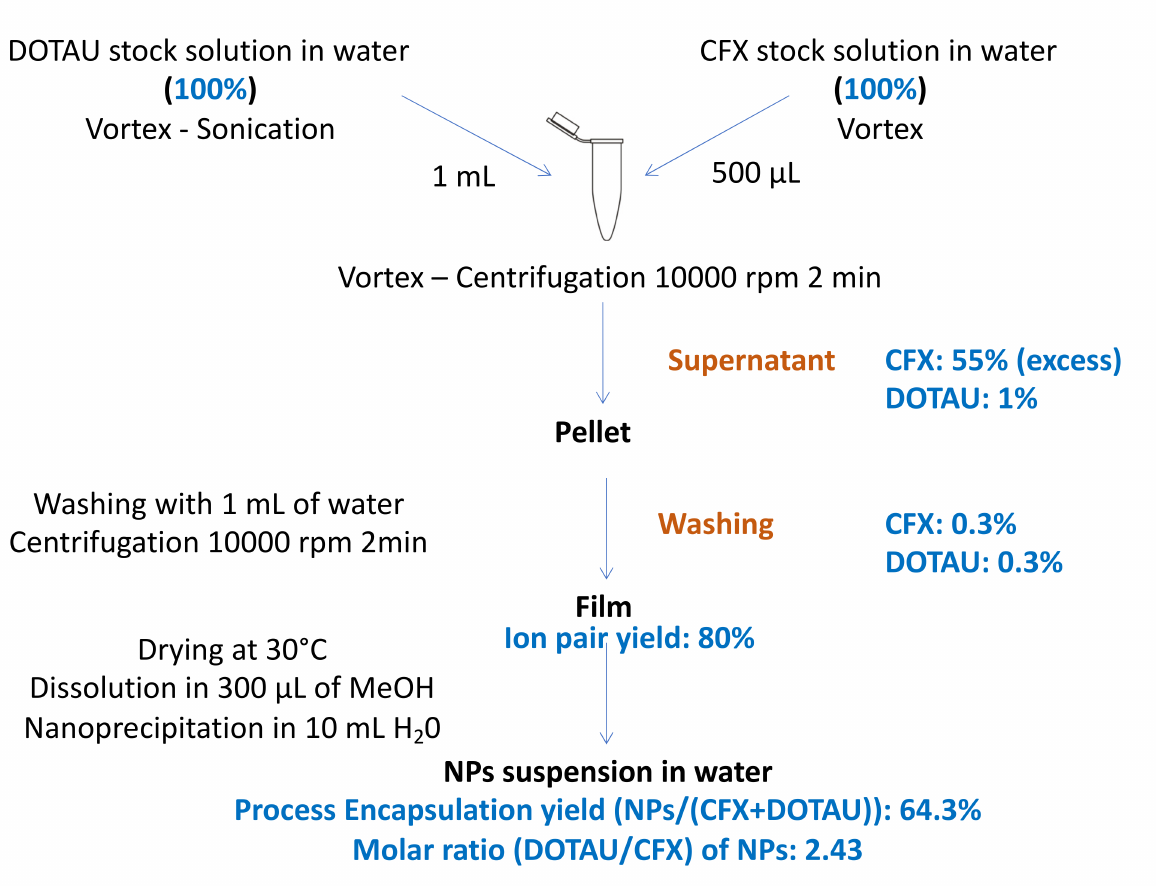
Figure 3. Optimized formulation protocol and HPLC analysis results (in blue).